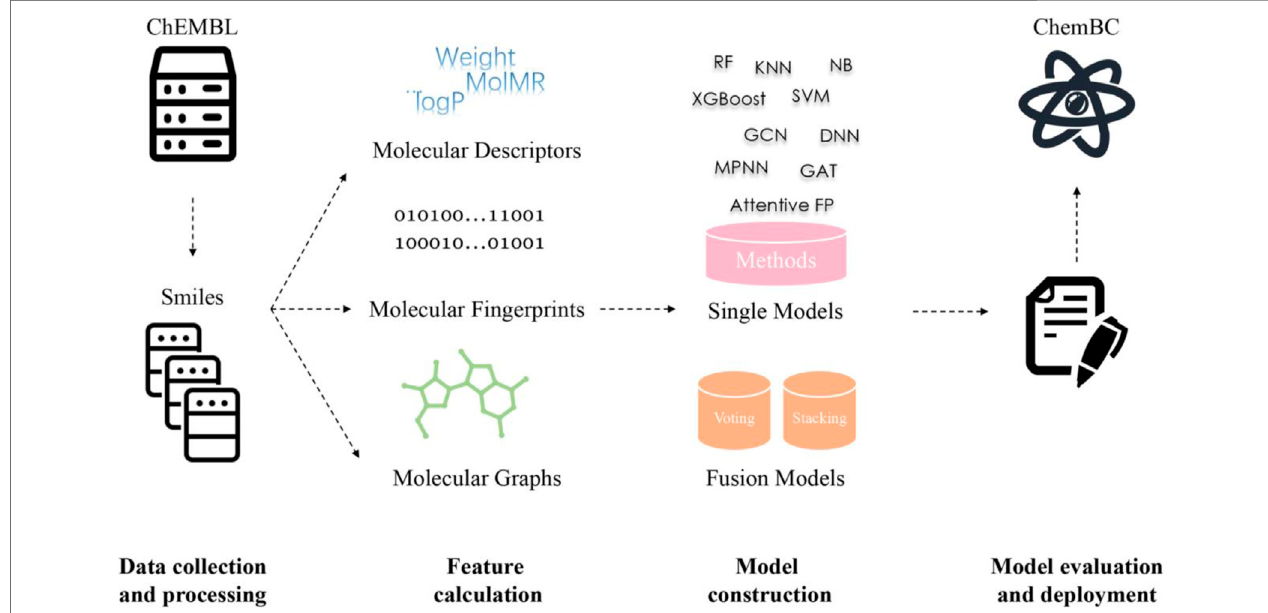
FIGURE 1 | Model construction